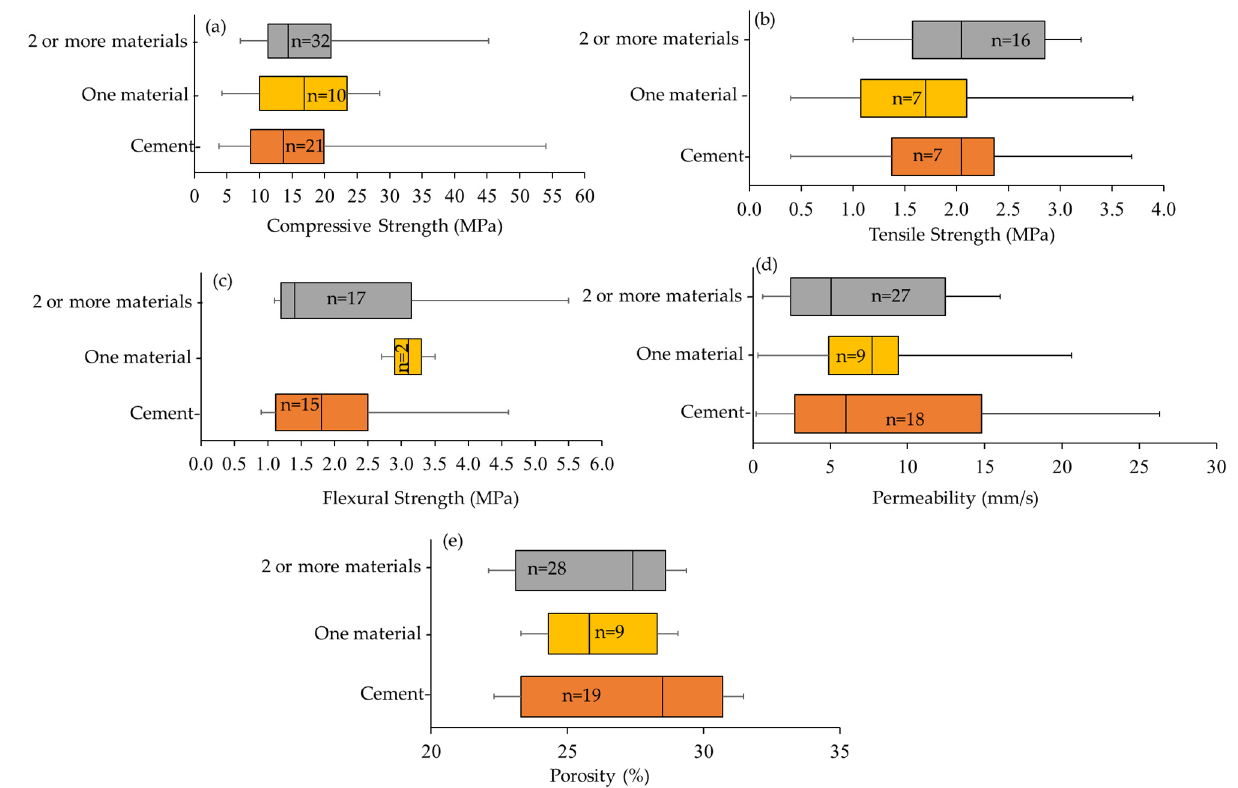
Figure 6. Variation in ( a ) Compressive strength, ( b ) Tensile strength, ( c ) Flexural strength, ( d ) Permeability, and ( e ) Porosity based on number of SCMs (n = number of publications).